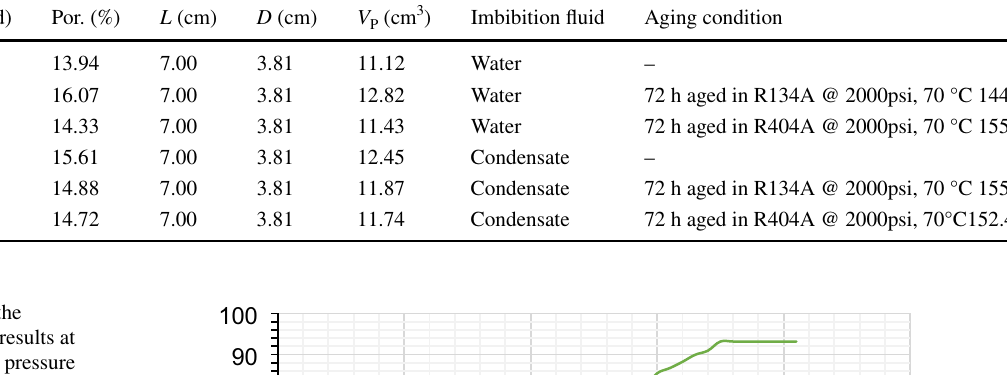
Table 8 Information about the plugs used in the imbibition tests Plug no.